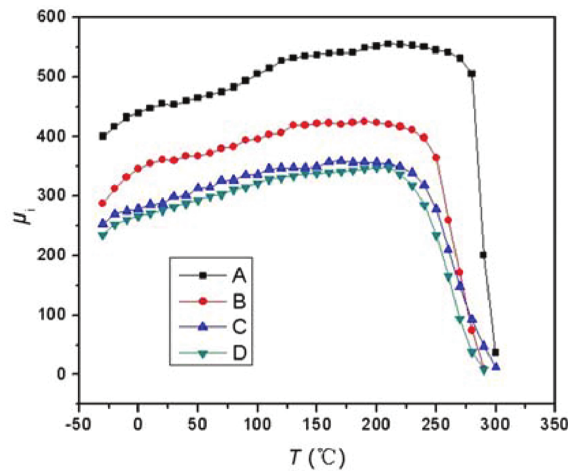
Figure 3: Thermal variation of initial permeability ( μ i ) for NiZn ferrite samples.